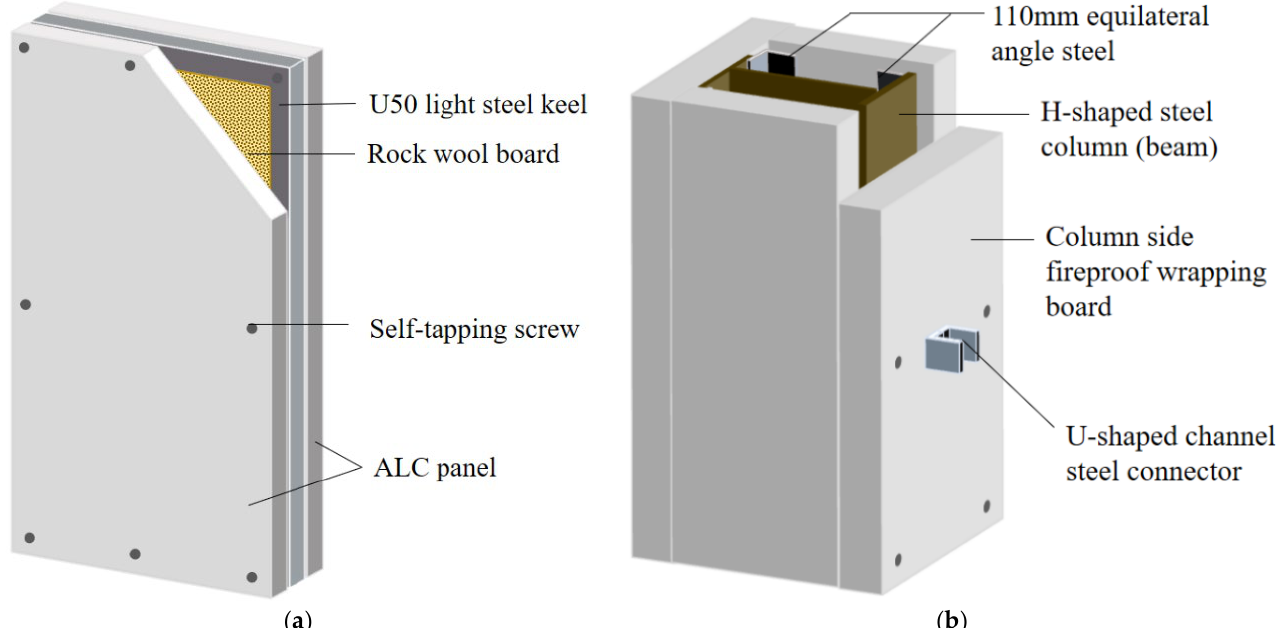
Figure 1. The prefabricated integrated enclosure panel system consisting of part ( a ) and part ( b ).